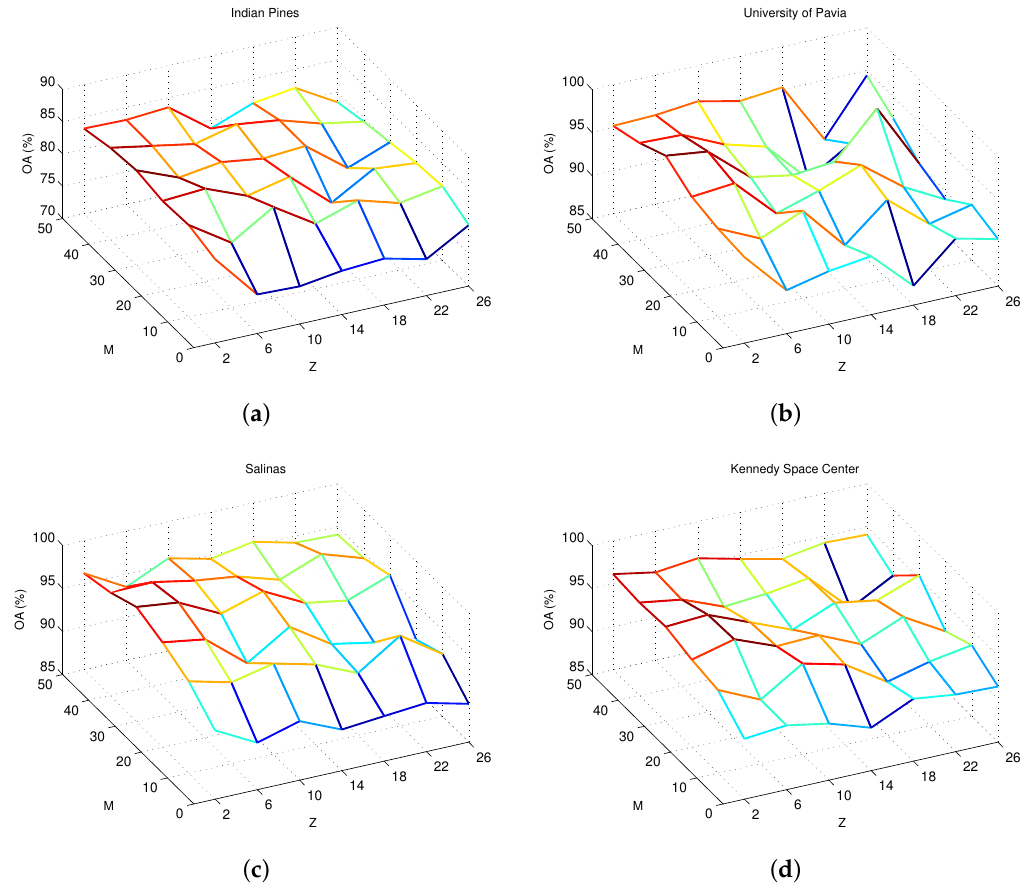
Figure 8. Experimental results. ( a ) the results for the Indian Pines data set; ( b ) the results for University of Pavia data set; ( c ) the results for Salinas data set; ( d ) the results for Kennedy Space Center data